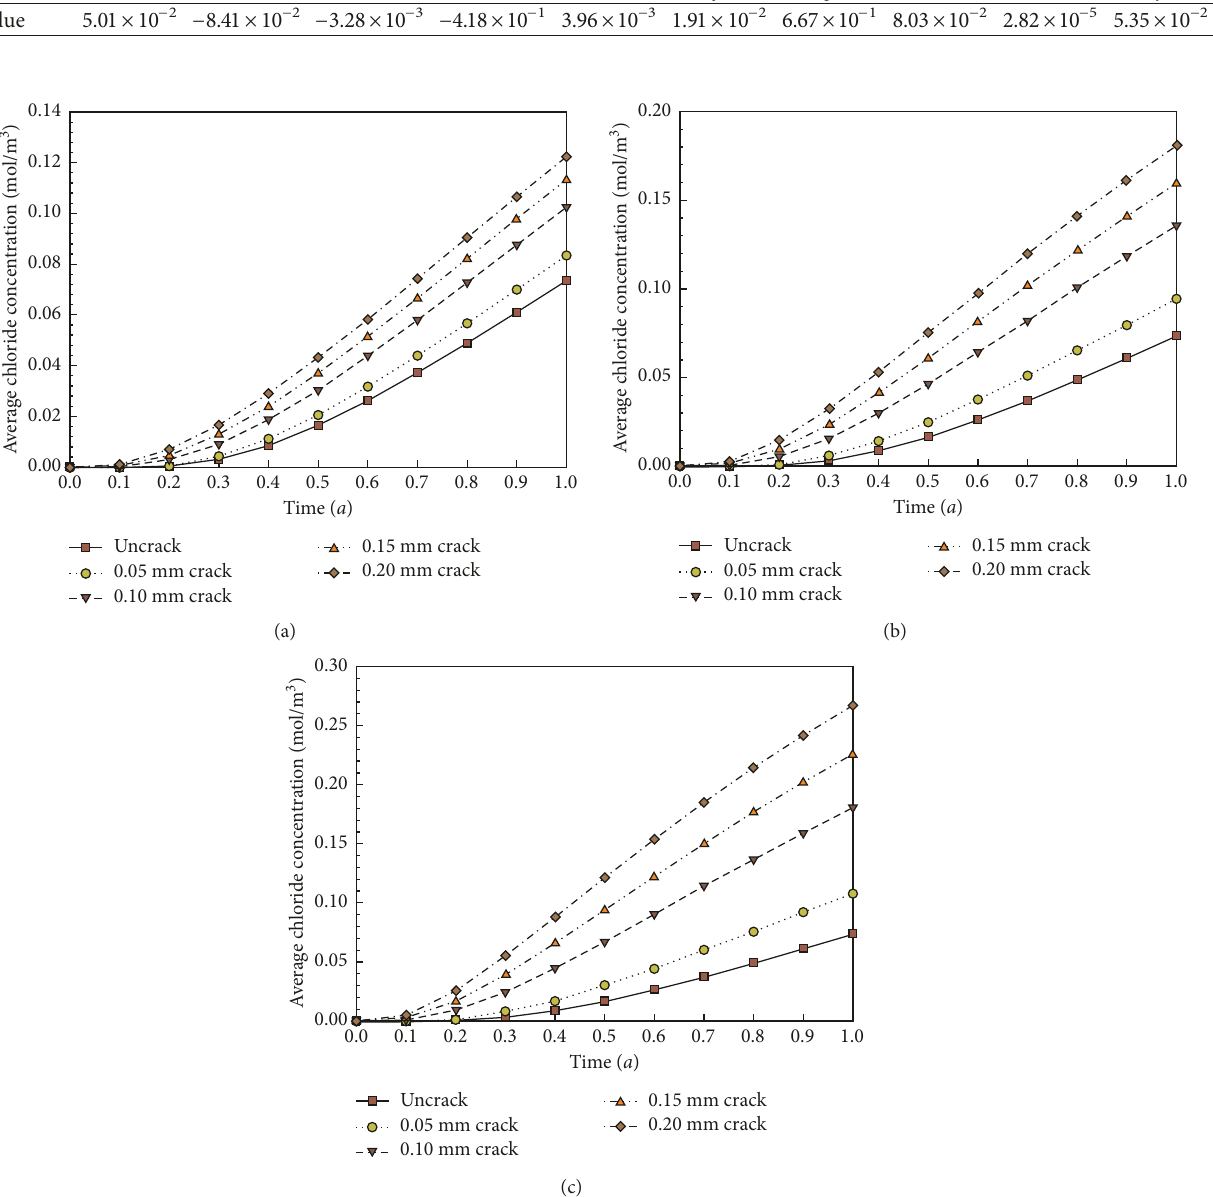
Figure 14: Comparisons of average chloride concentration on the surface of the rebar between models (different crack widths and frequency). . Crack frequency: (a) 10, (b) 20, and (c)